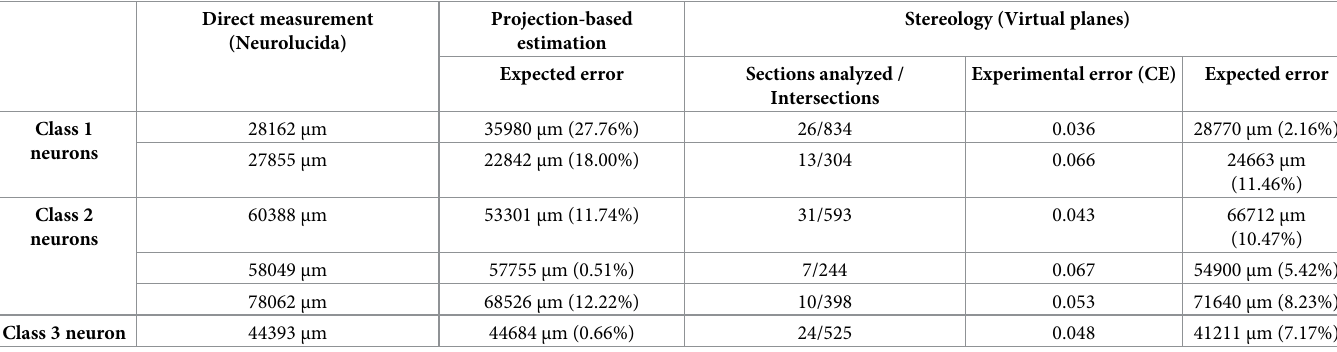
Table 1. Differences between the three axonal length estimation methods after their practical implementation. Direct measurement